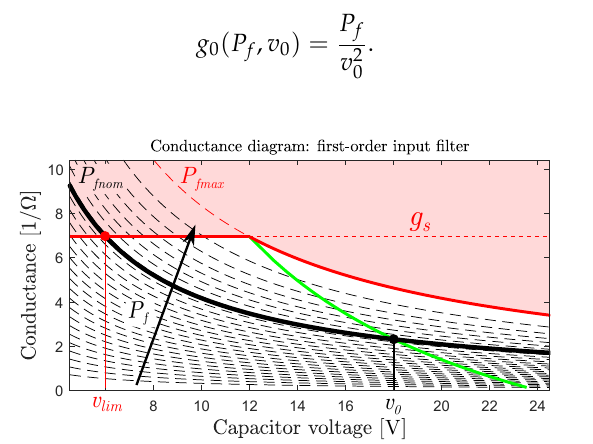
Figure 7. First-order filter conductance diagram for variable filter power P f